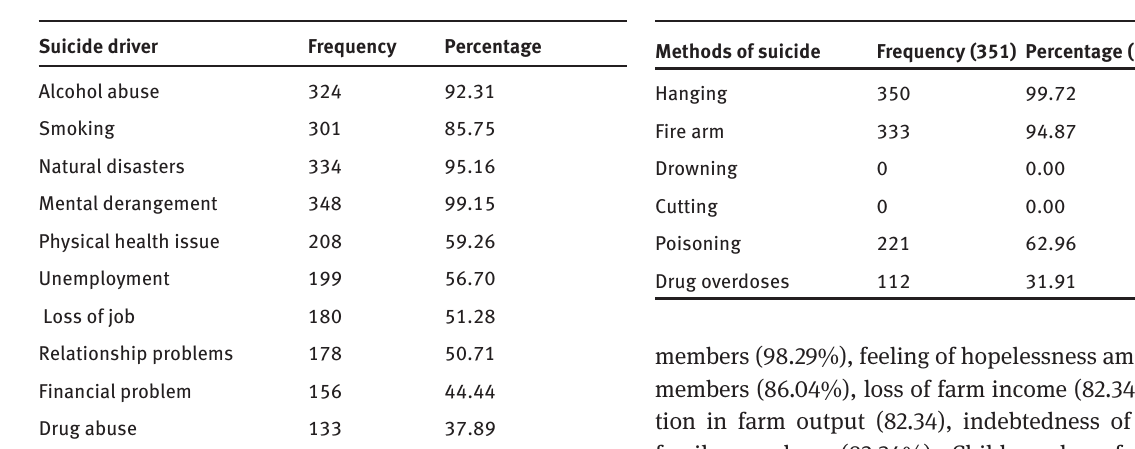
Table 5 : Perception of methods of committing suicide